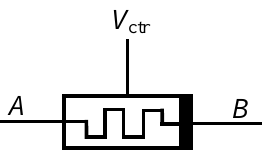
Figure 9. Simplified symbol of threshold-controllable memristor.